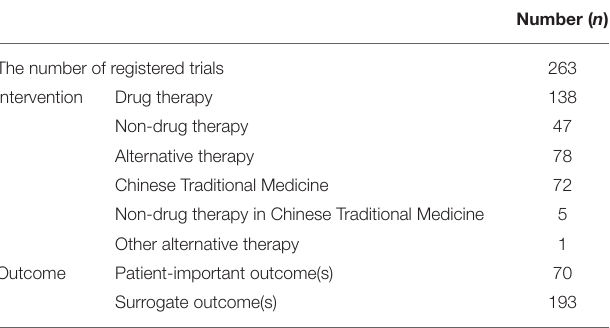
TABLE 1 | The baseline of the included registered